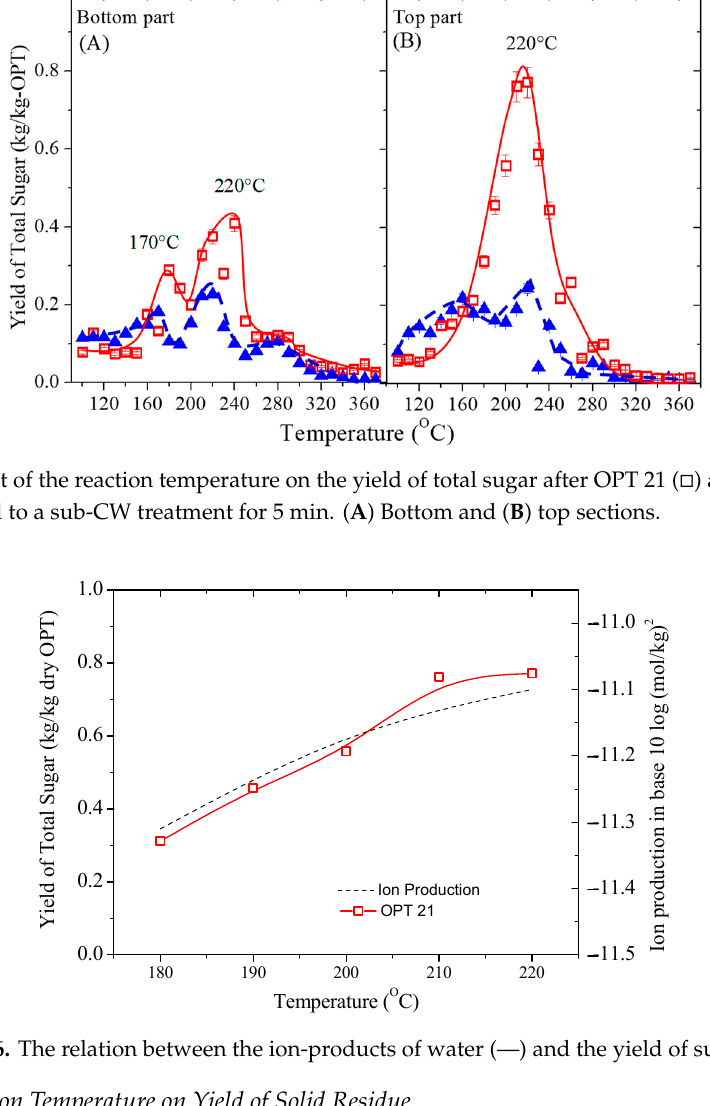
Figure 6. The relation between the ion-products of water (---) and the yield of sugar ( □ ).